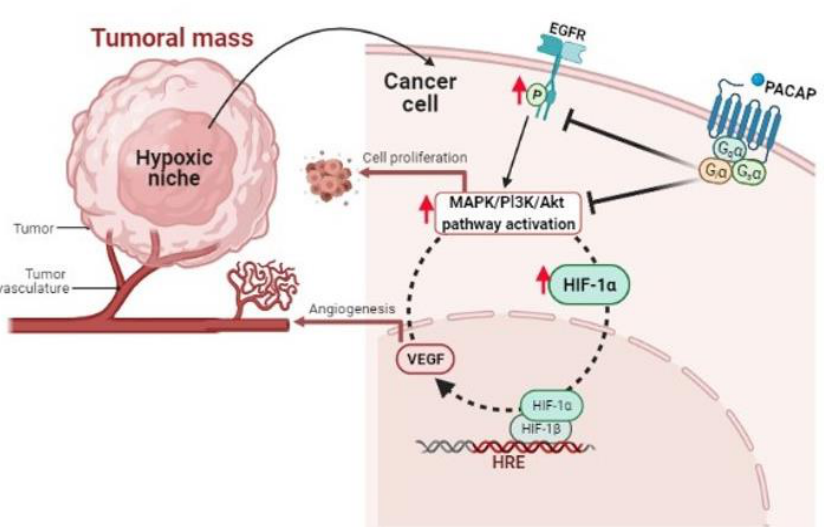
Figure 1. Schematic representation showing the PACAP modulatory effect in cellular microenviron- ment of hypoxic niches.